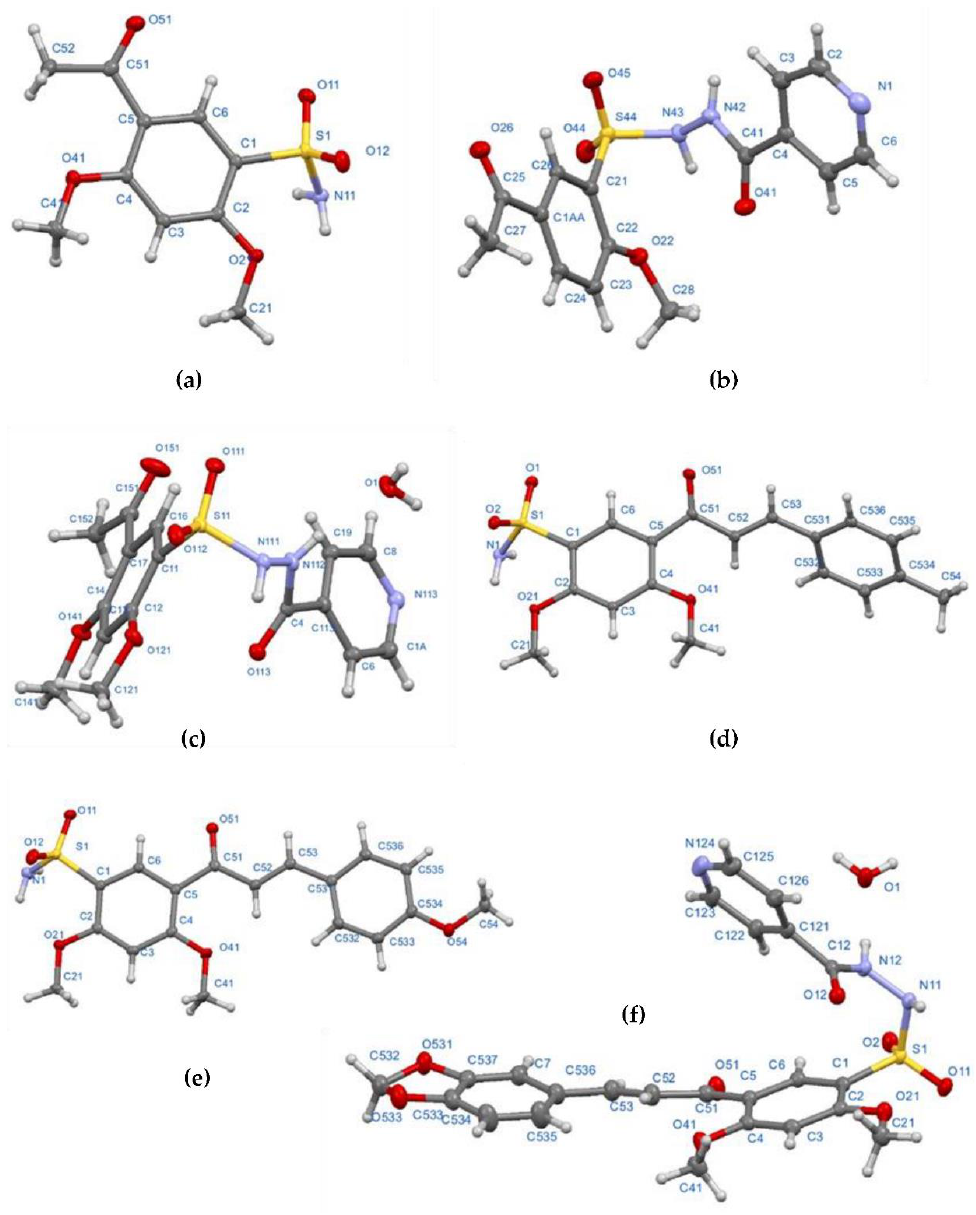
Figure 2. Molecular structure of compounds 8b ( a ), 14a ( b ), 14b ( c ), 17c ( d ), 17d ( e ) and 20f ( f ) determined from single-crystal X-ray diffraction, showing the atom-labelling scheme. Single crystal diffraction experimental details can be found in Table S1 (see Supplementary Materials).